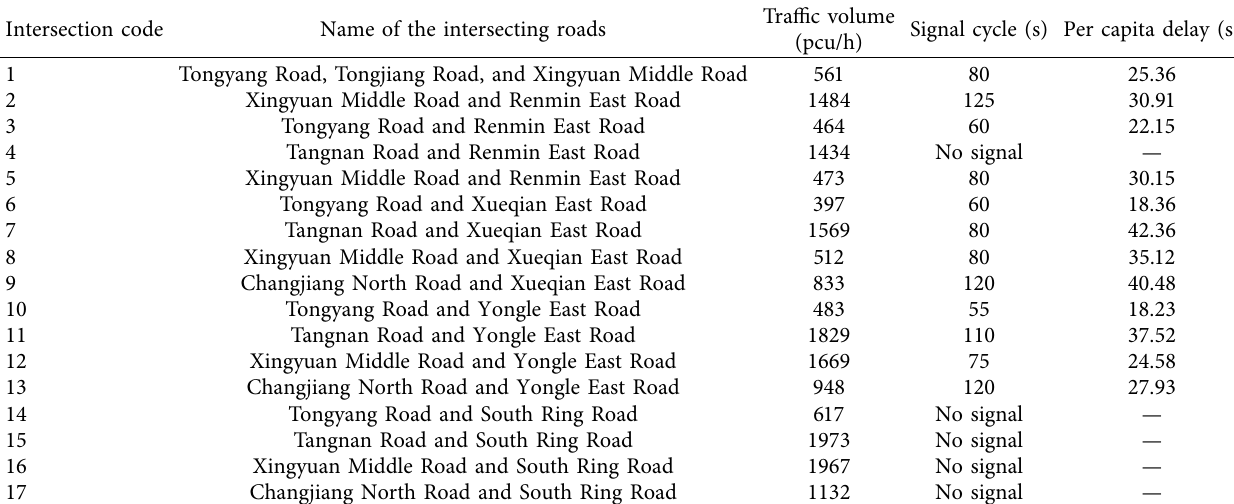
Table 8: Operation efficiency of the intersections.